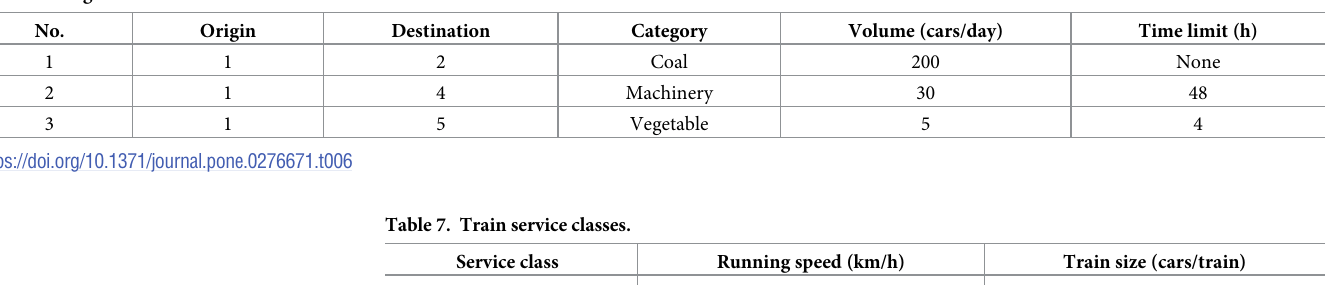
Table 6. Freight demands.